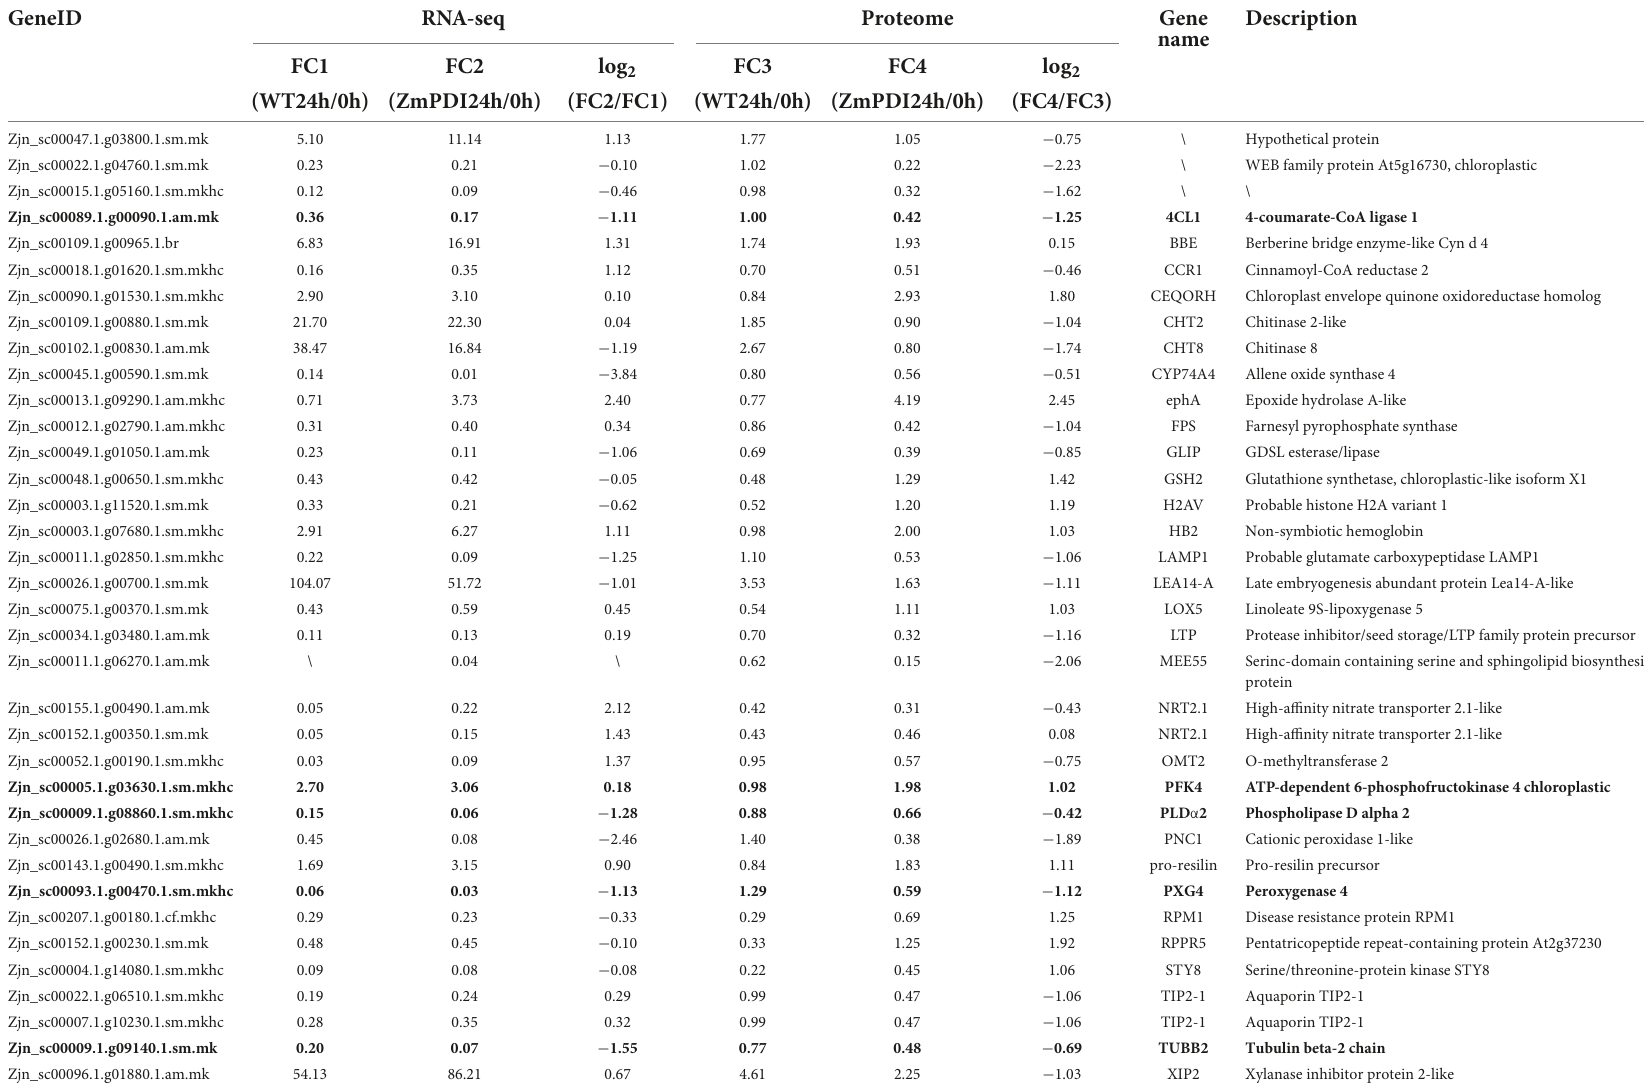
TABLE 1 Selected differentially expressed genes (DEGs) from transcriptome and proteome association analysis. GeneID RNA-seq